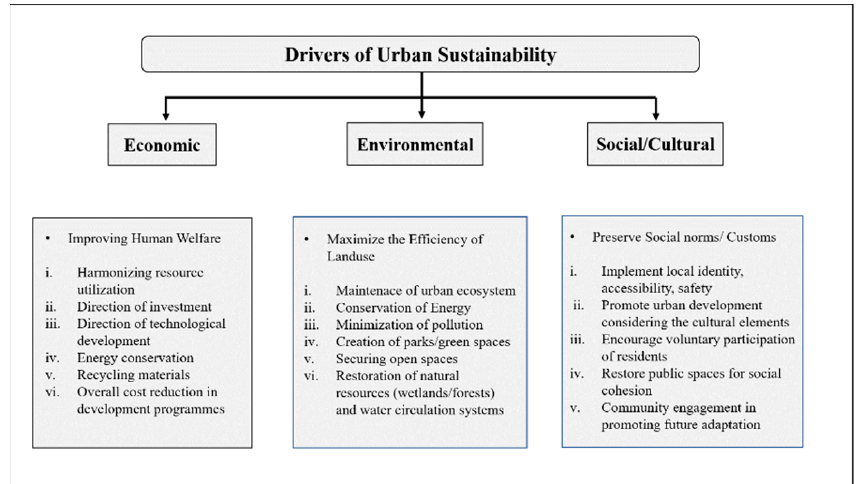
Figure 2. The current society’s sustainable development concept is explained as covering economic, environmental, and socio-cultural factors. Source: Author.